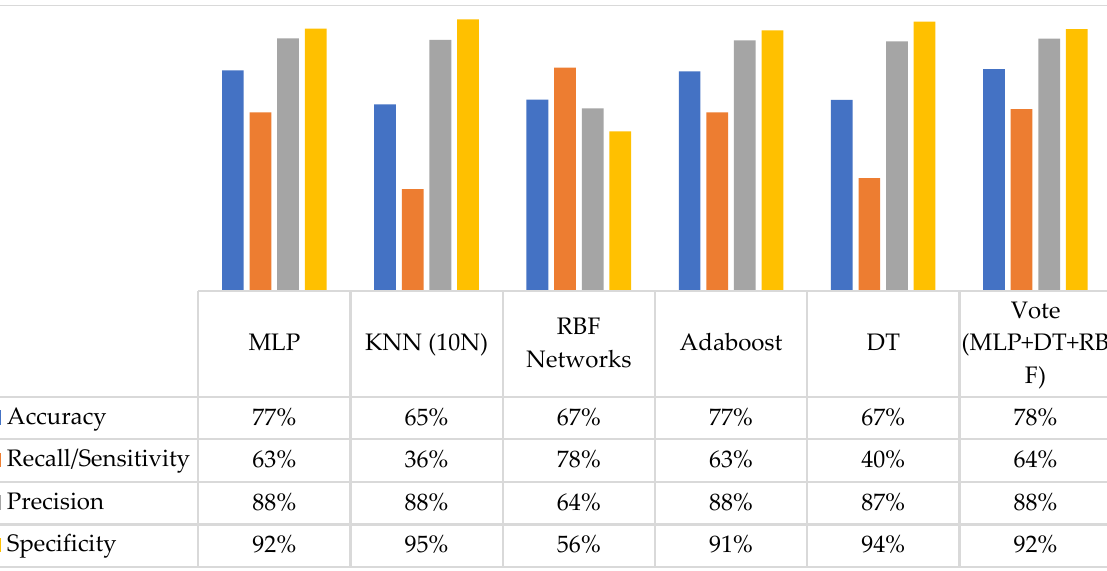
Figure 2. Performance of the classifiers in terms of four evaluation metrics on third model. Due to poor recall, KNN (36%) and DT (40%) were not deemed appropriate candidates to support OCRAT. RBF networks showed the highest recall value. However, due to its low specificity, it was eliminated from the next round of measurements. The remaining classifiers, MLP, AdaBoost, and voting algorithm, were investigated in more detail by applying ROC and RP curves. The calculated AUC for the ROC and RP curves for MLP, AdaBoost, and the voting algorithm are illustrated in Figure 3.